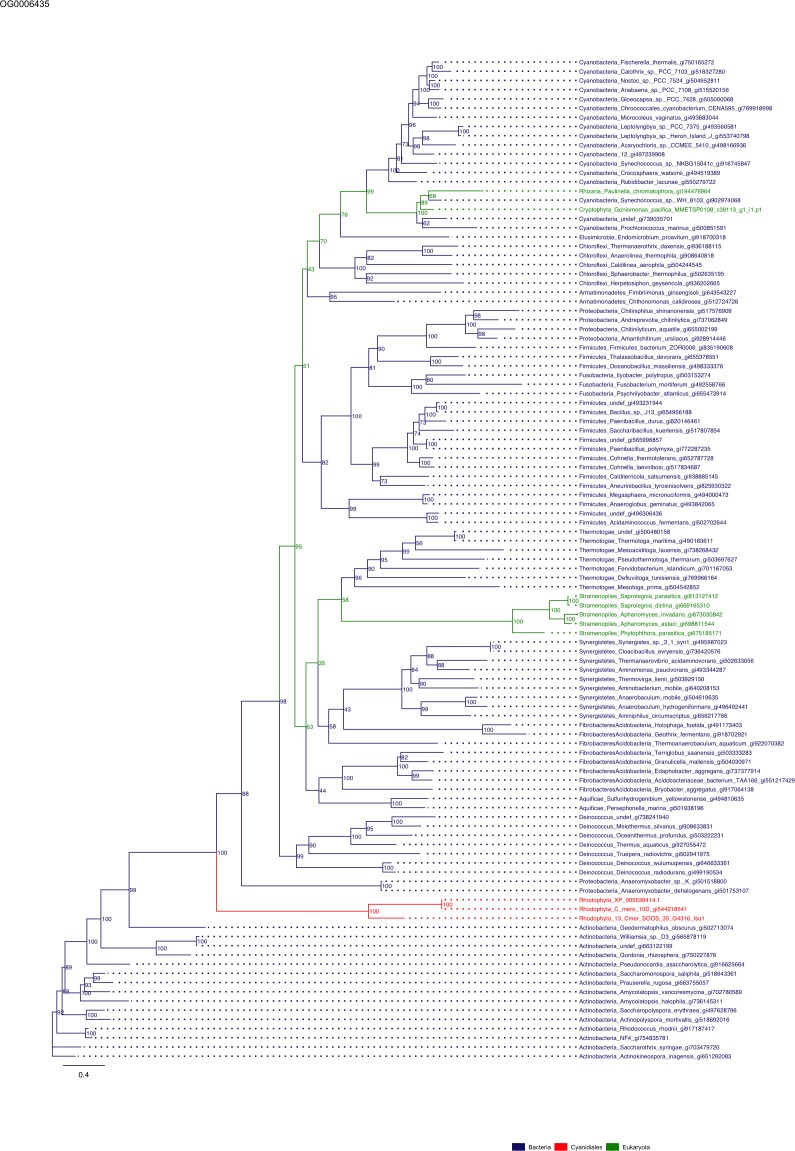
Sequence tree of orthogroup OG0006435.The tree is based on amino acid sequences. Archaea (yellow), Bacteria (blue), Cyanidiales (red), Eukaryotes including other red algae (green). Branches containing Cyanidiales sequences are highlited in red.